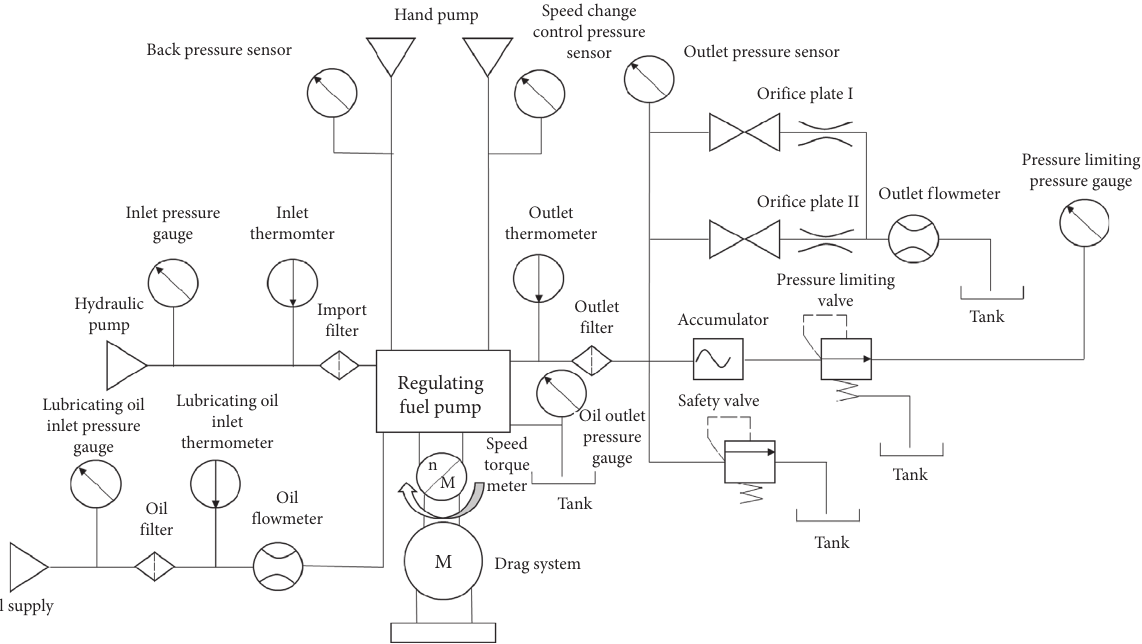
Figure 3: Schematic of the experimental setup. Table 2: Error analysis between experimental measurements and numerical simulations.